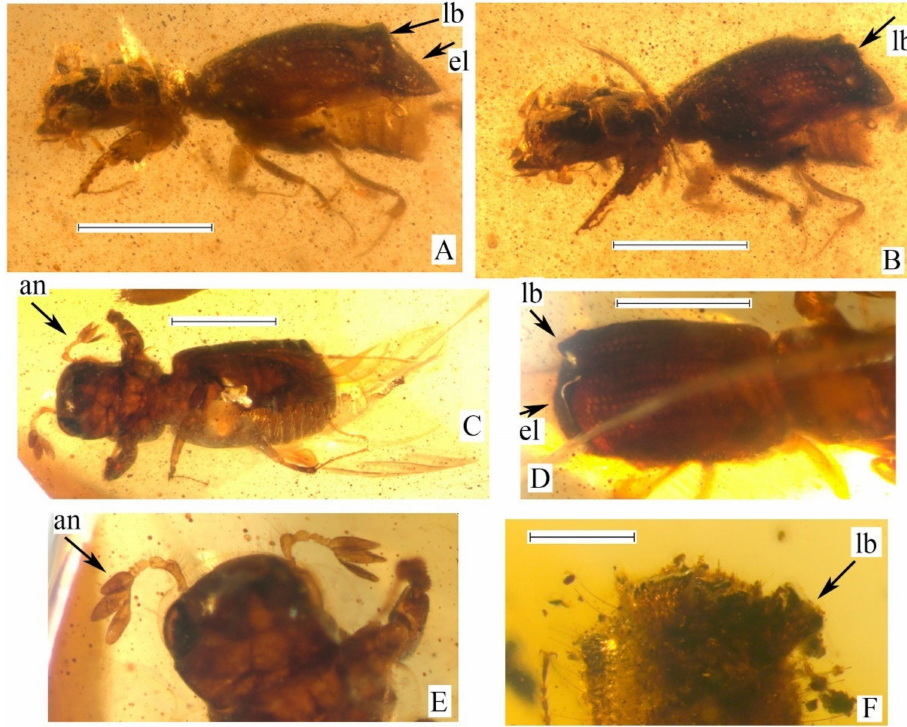
Figure 4. Poinarinius spp. in Myanmar amber: ( A ) P . cretaceus sp. nov., paratype, male, ISEA MA2020/5, lateral view; ( B ) P . cretaceus sp. nov., paratype, male, ISEA MA2020/5, dorso-lateral view; ( C ) P . cretaceus sp. nov., holotype, male, ISEA MA2018/4, ventral view; ( D ) P . cretaceus sp. nov., holotype, male, ISEA MA2018/4, elytra, dorso-lateral view; ( E ) P. cretaceus sp. nov., holotype, male, ISEA MA2018/4, antennae and head, ventral view; ( F ) P . lesnei sp. nov., holotype, female, ISEA MA2018/9, elytral cavity, dorsal view. Scale bar 1.0 mm. Abbreviations: lb—lobe, el—elytral declivity,